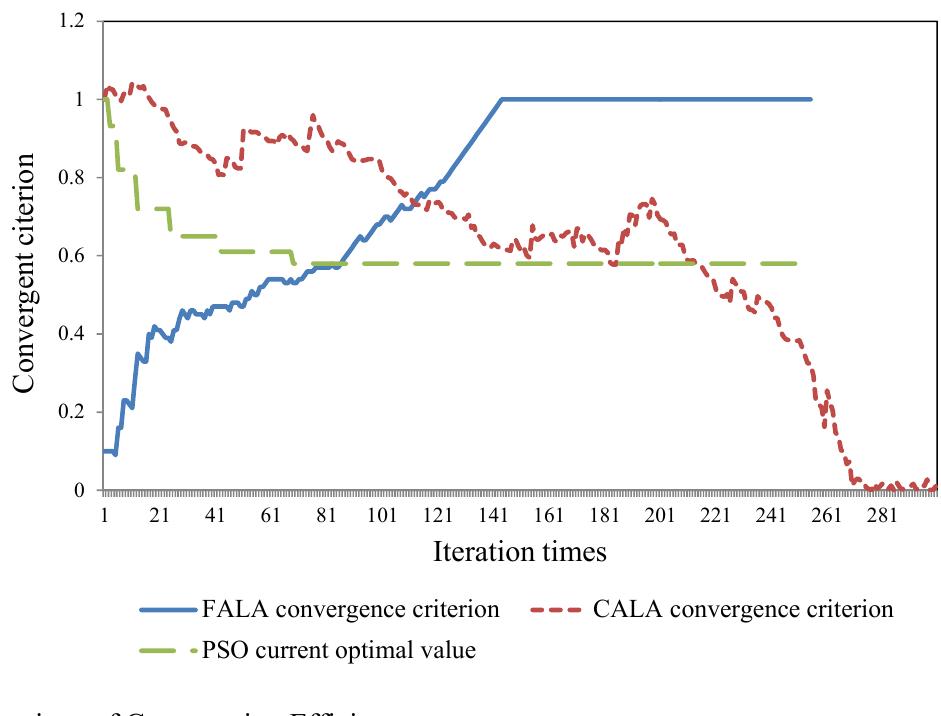
Figure 5. Convergence characteristics of three algorithms.